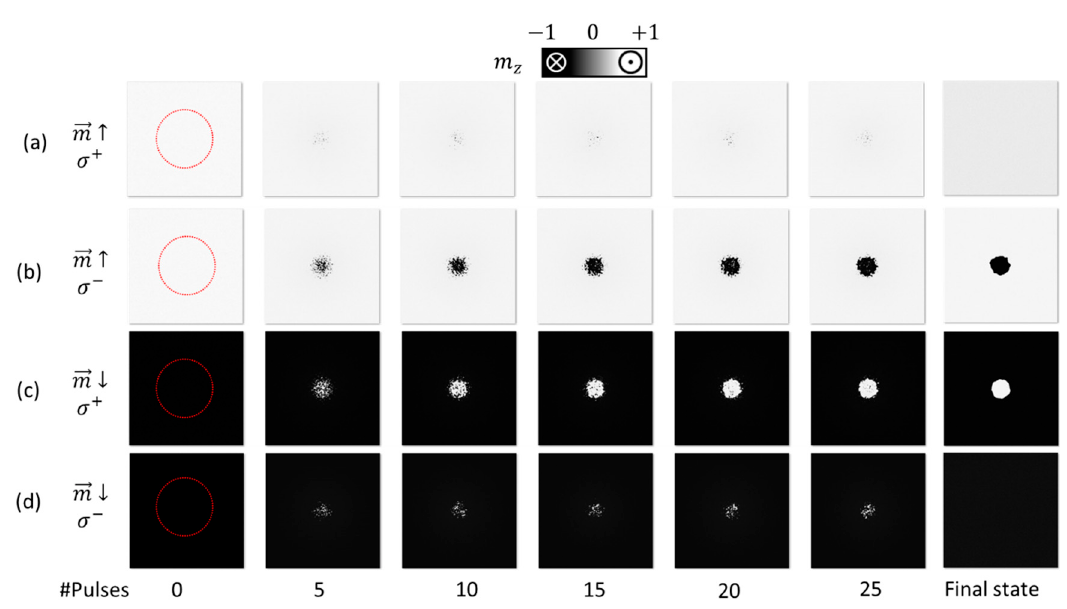
Figure 5. Magnetization snapshots after several pulses under the influence of the MCD. Results are shown for right-handed ( σ + ) ( a ) and ( c ) and left-handed ( σ − ) ( b ) and ( d ) circular polarization of the laser beam, and initial magnetic states pointing up ( 𝑚 ↑ ) ( a ) and ( b ) or down ( 𝑚 ↓ ) ( c ) and ( d ). The fluence and the MCD absorption rate are F = 0.5 J/m 2 and MCD = 10% respectively. A video of these HD-AOS is provided as Supplementary Material (video S1).